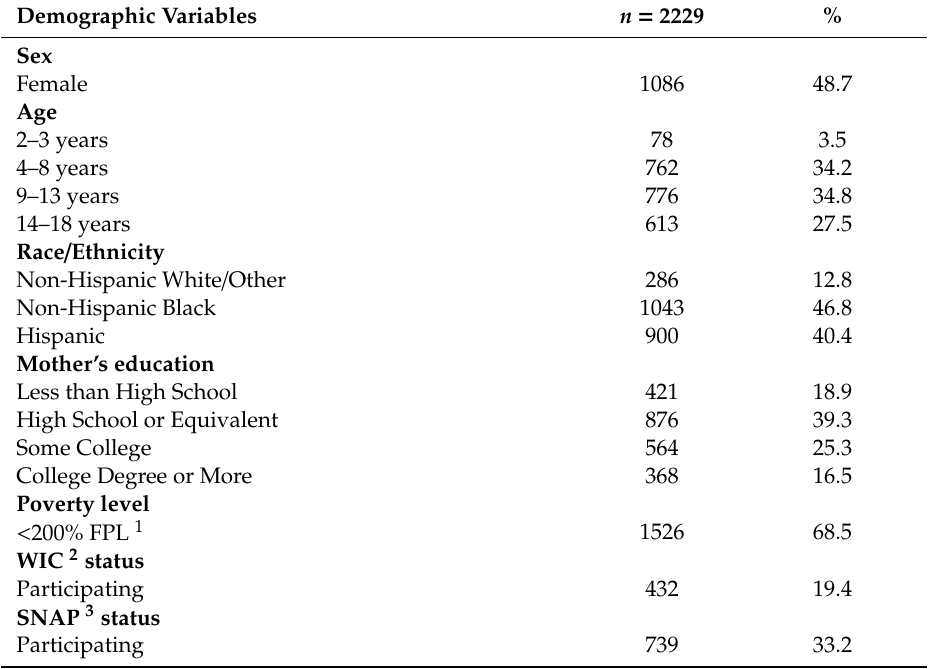
Table 1. Demographic characteristics of children in the analytical sample from the New Jersey Child Health